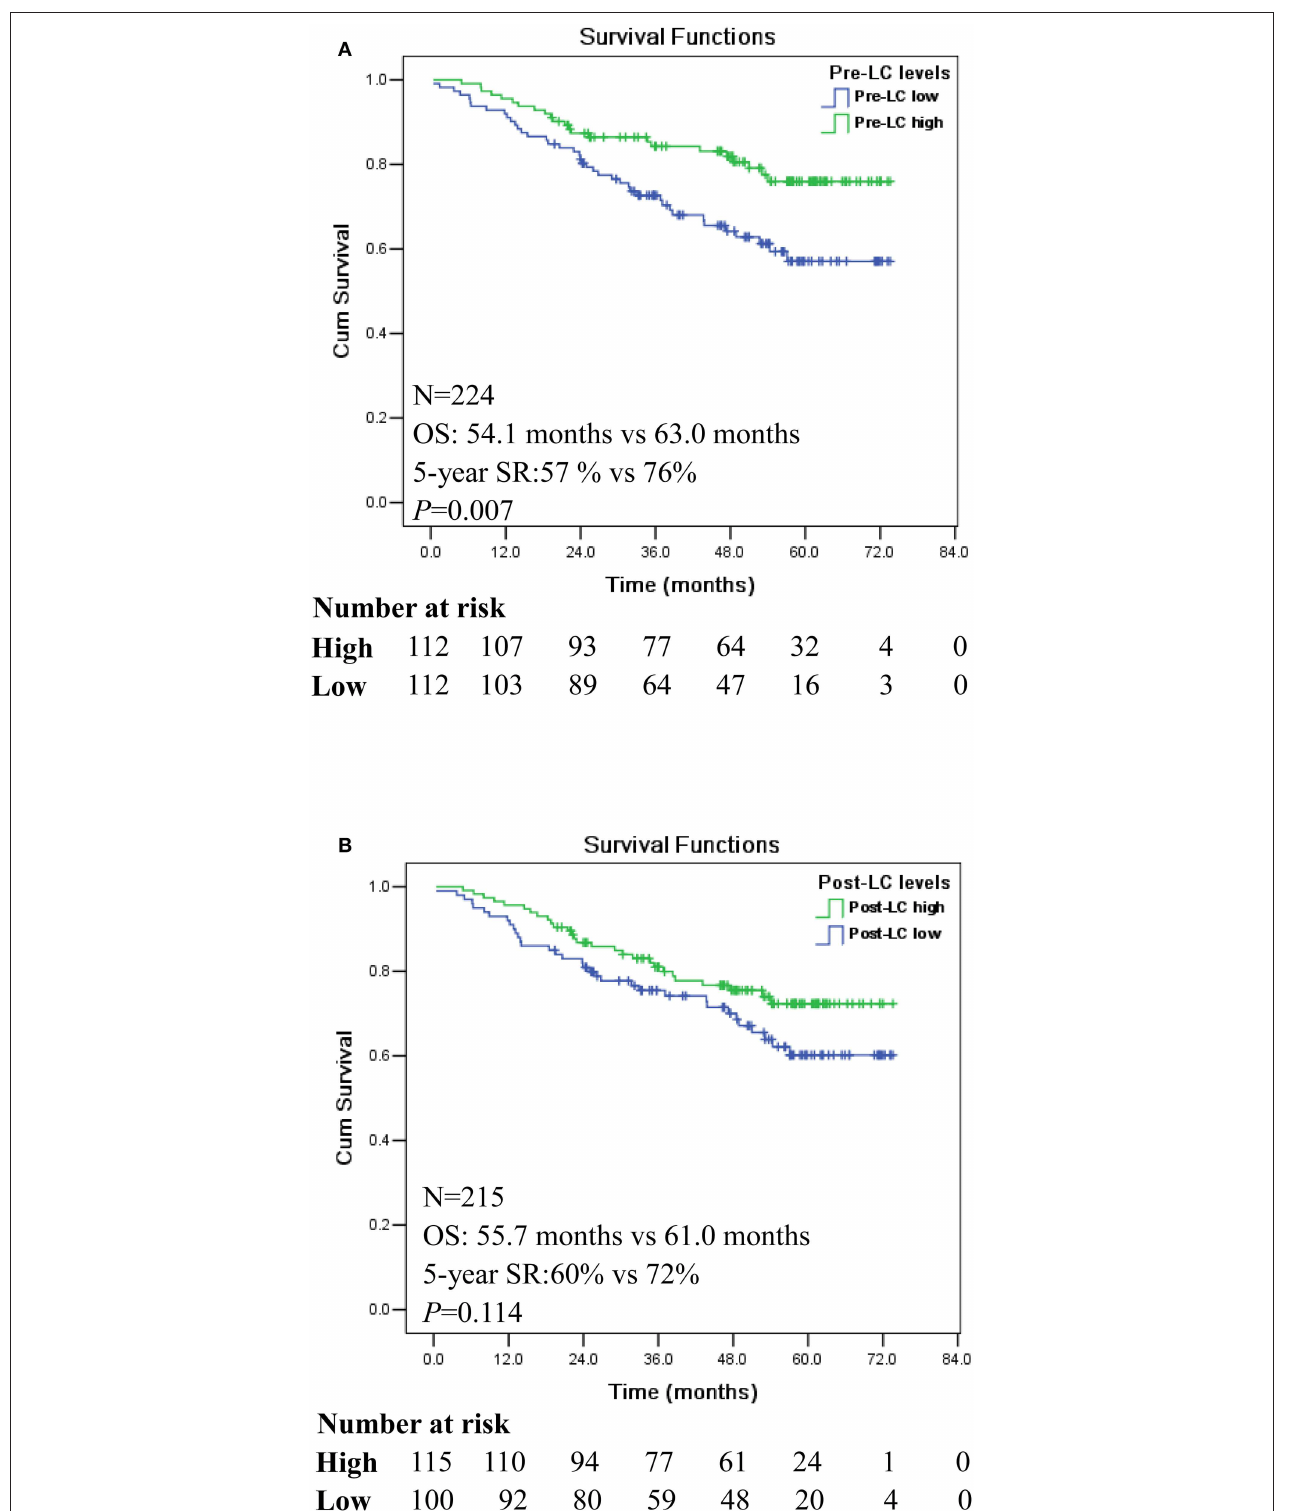
FIGURE 1 | Kaplan-Meier survival analysis between the high and low levels of pre- and post-operation peripheral lymphocyte count (LC) in CRC patients. (A) Comparison of overall survival between pre-LC high and pre-LC low among CRC patients. (B) Comparison of overall survival between post-LC high and post-LC low among CRC